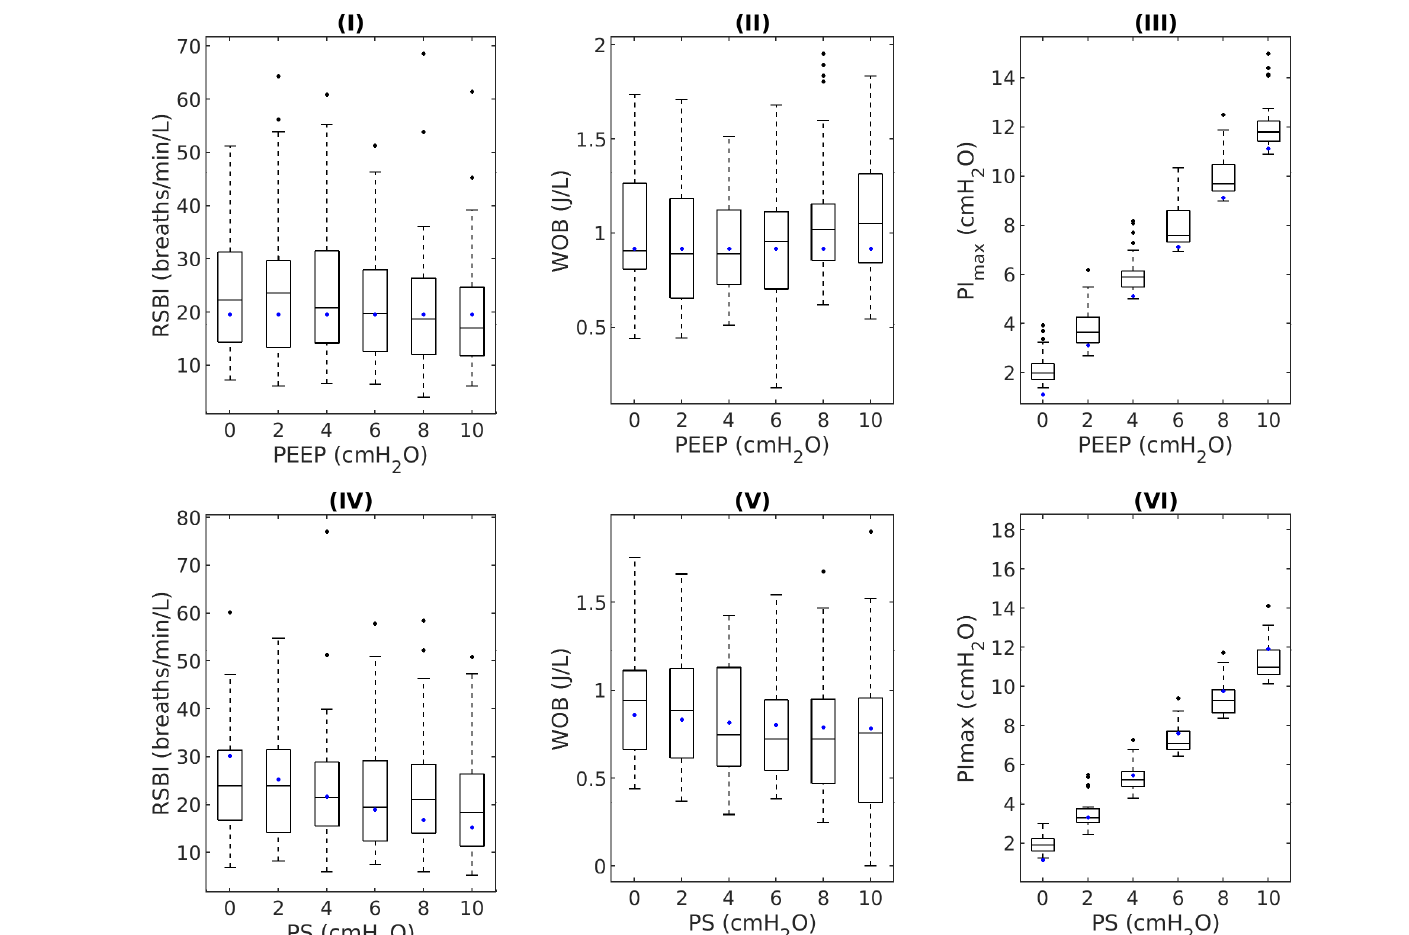
Figure 7. Resulting population distribution for Test D (upper row with PS = 0 cmH 2 O) and Test E (lower row with PEEP = 0 cmH 2 O), showing the experimental information obtained from the DB in black and the response of the model to input parameters (medians of I: E, R, C, P musc and RR reported in Table 2) in blue dots for ( I ) and ( IV ) Tobin Index; ( II ) and ( V ) Work of breathing; ( III ) and ( VI ) Maximal inspiratory